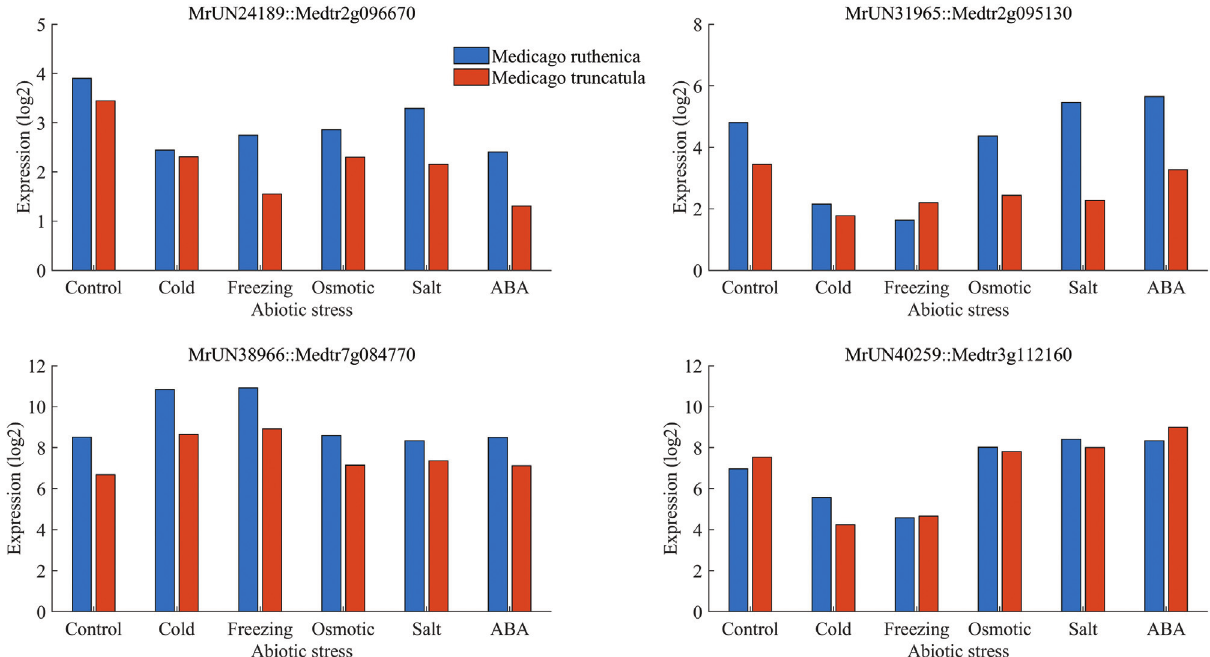
Figure 7 - Comparisons of the expression profiles of four Medicago ruthenica unigenes that are differentially expressed in the response to abiotic stress and their homologs in M. truncatula . Four pairs of homologous genes from Medicago ruthenica and M. truncatula show similar expression profiles in